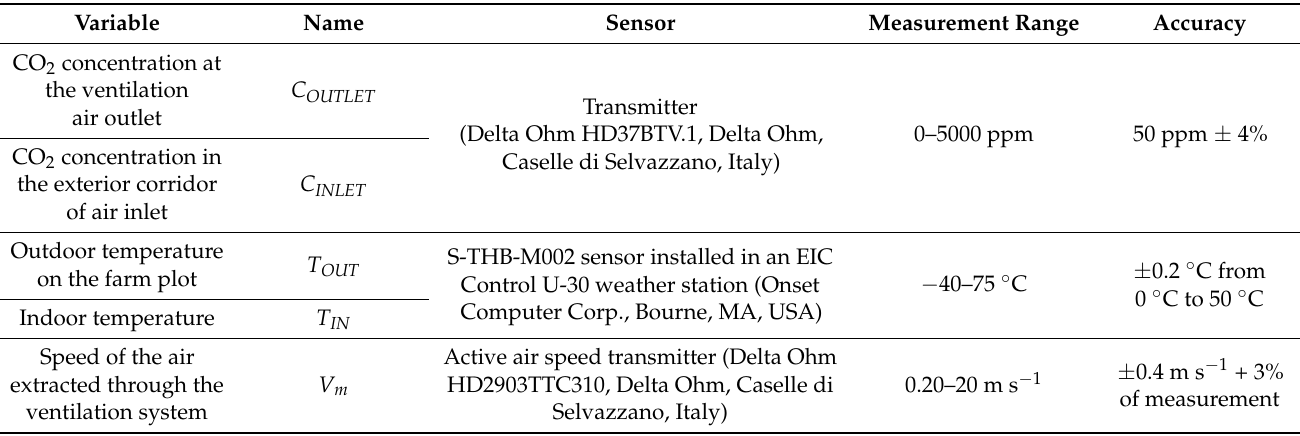
Table 2. Variables measured and sensors used in the experimental